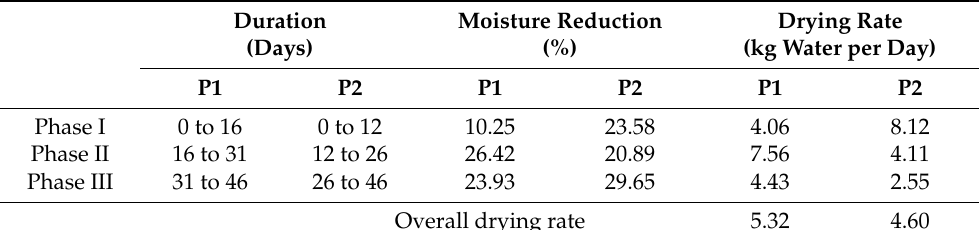
Table 3. Drying rates of waste